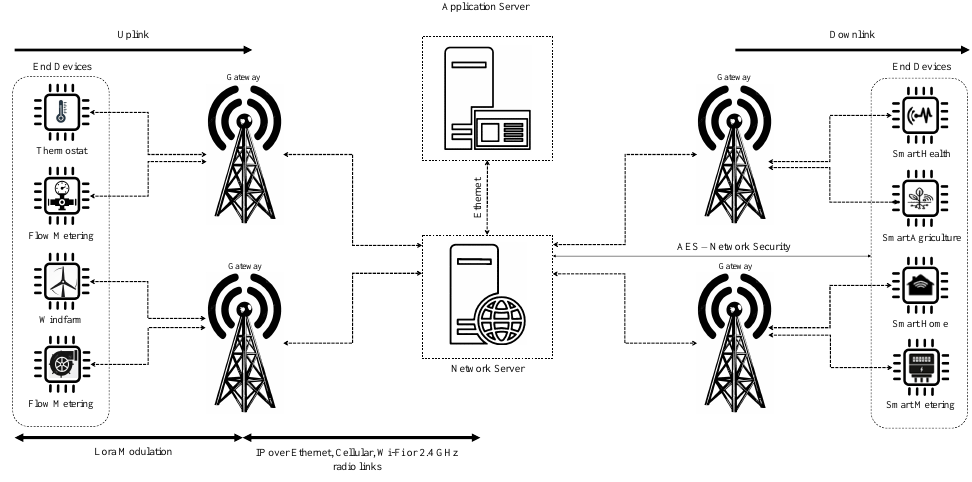
Figure 2. LoRaWAN network